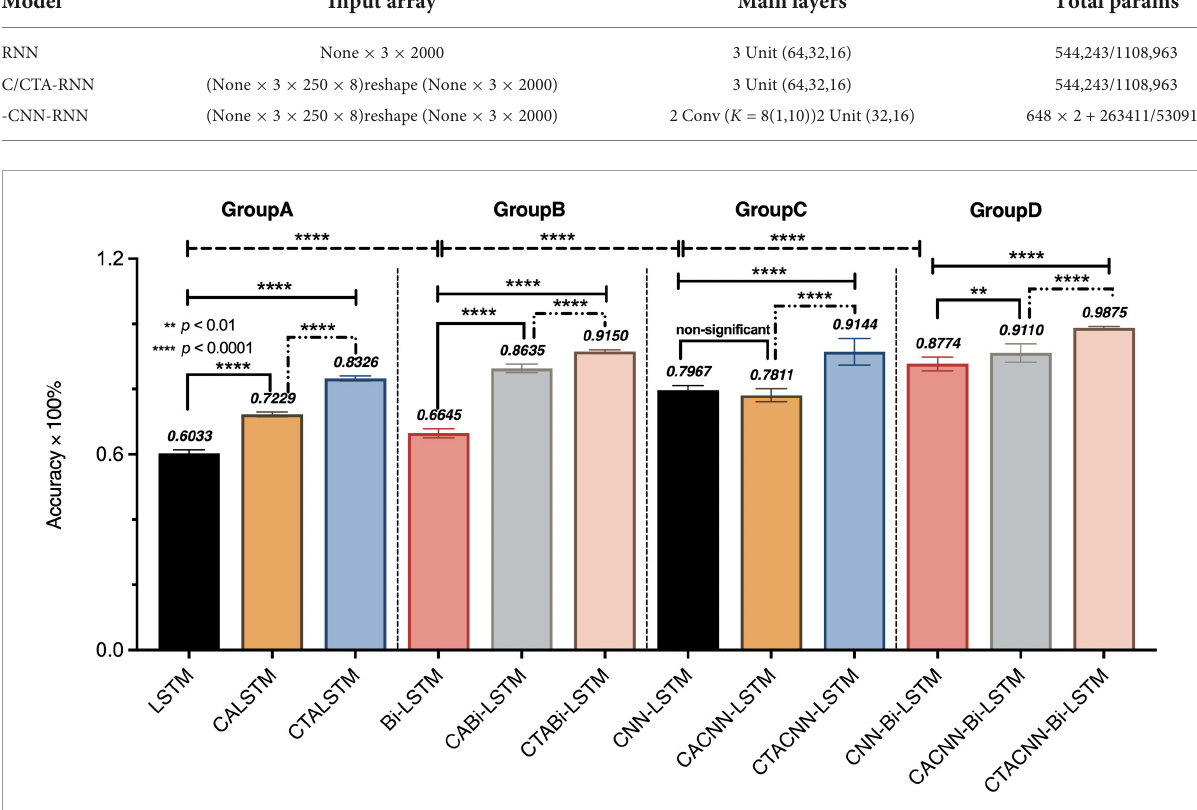
FIGURE5 The results of mean accuracy (%) and one-way ANOVA in baseline and proposed methods on 3s-data set. The symbol ** means that P < 0.01 and is a statistically significant difference. The symbol **** means that P < 0.0001 is an extremely significant statistical